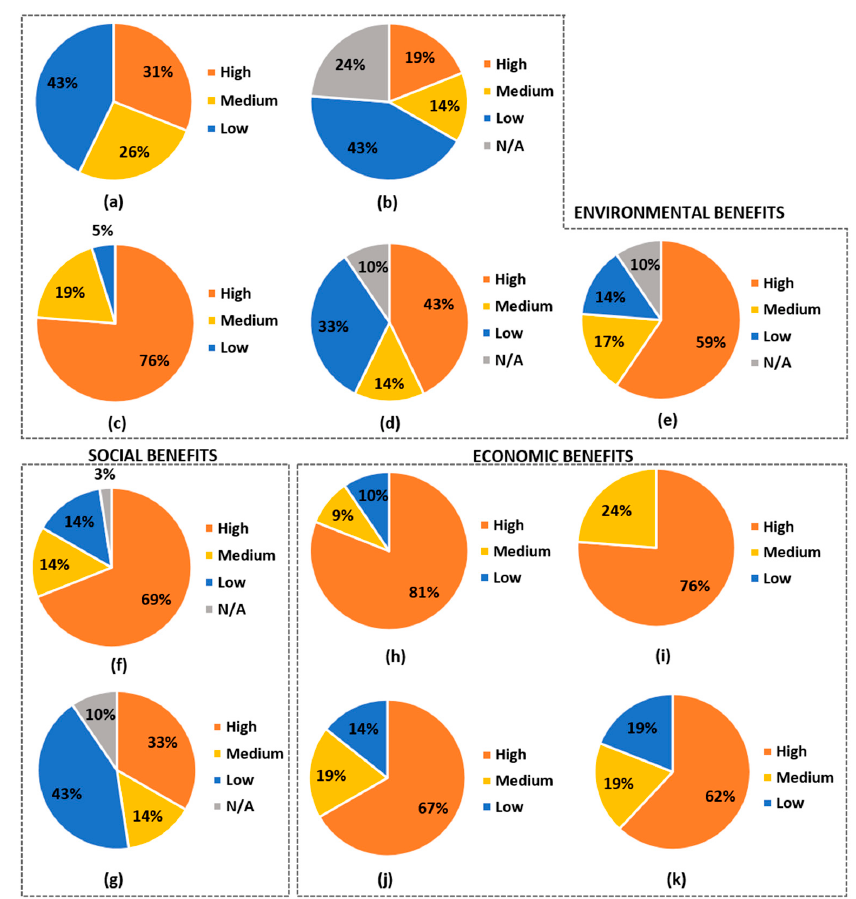
Figure 7. Answers obtained to the question of how important each benefit is: ( a ) pollution of water bodies; ( b ) Groundwater recharge; ( c ) enhancement of biodiversity and ecology; ( d ) heat stress reduction; ( e ) improvement of air quality; ( f ) increment of green spaces and amenity improvement; ( g ) food production; ( h ) water harvesting; ( i ) reduction of water pumping and treatment; ( j ) reduction of buildings energy consumption; ( k ) real estate value increment.